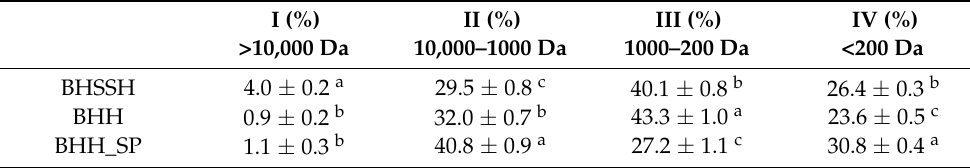
BHSSH = Baltic herring side stream hydrolysate; BHH = Baltic herring hydrolysate; and BHH_SP = Sep-Pak purified Baltic herring hydrolysate. Different superscript letters represent statistically different ( p < 0.05)